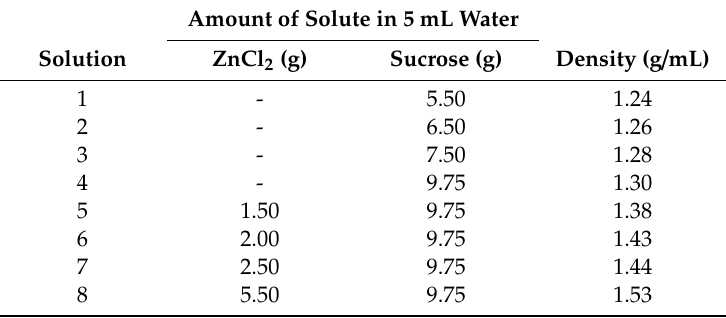
Table 1. Quantities of salt (ZnCl 2 ) and sucrose in 5 mL of Milli-Q water used for the density gradient solution preparation. The calculated densities are